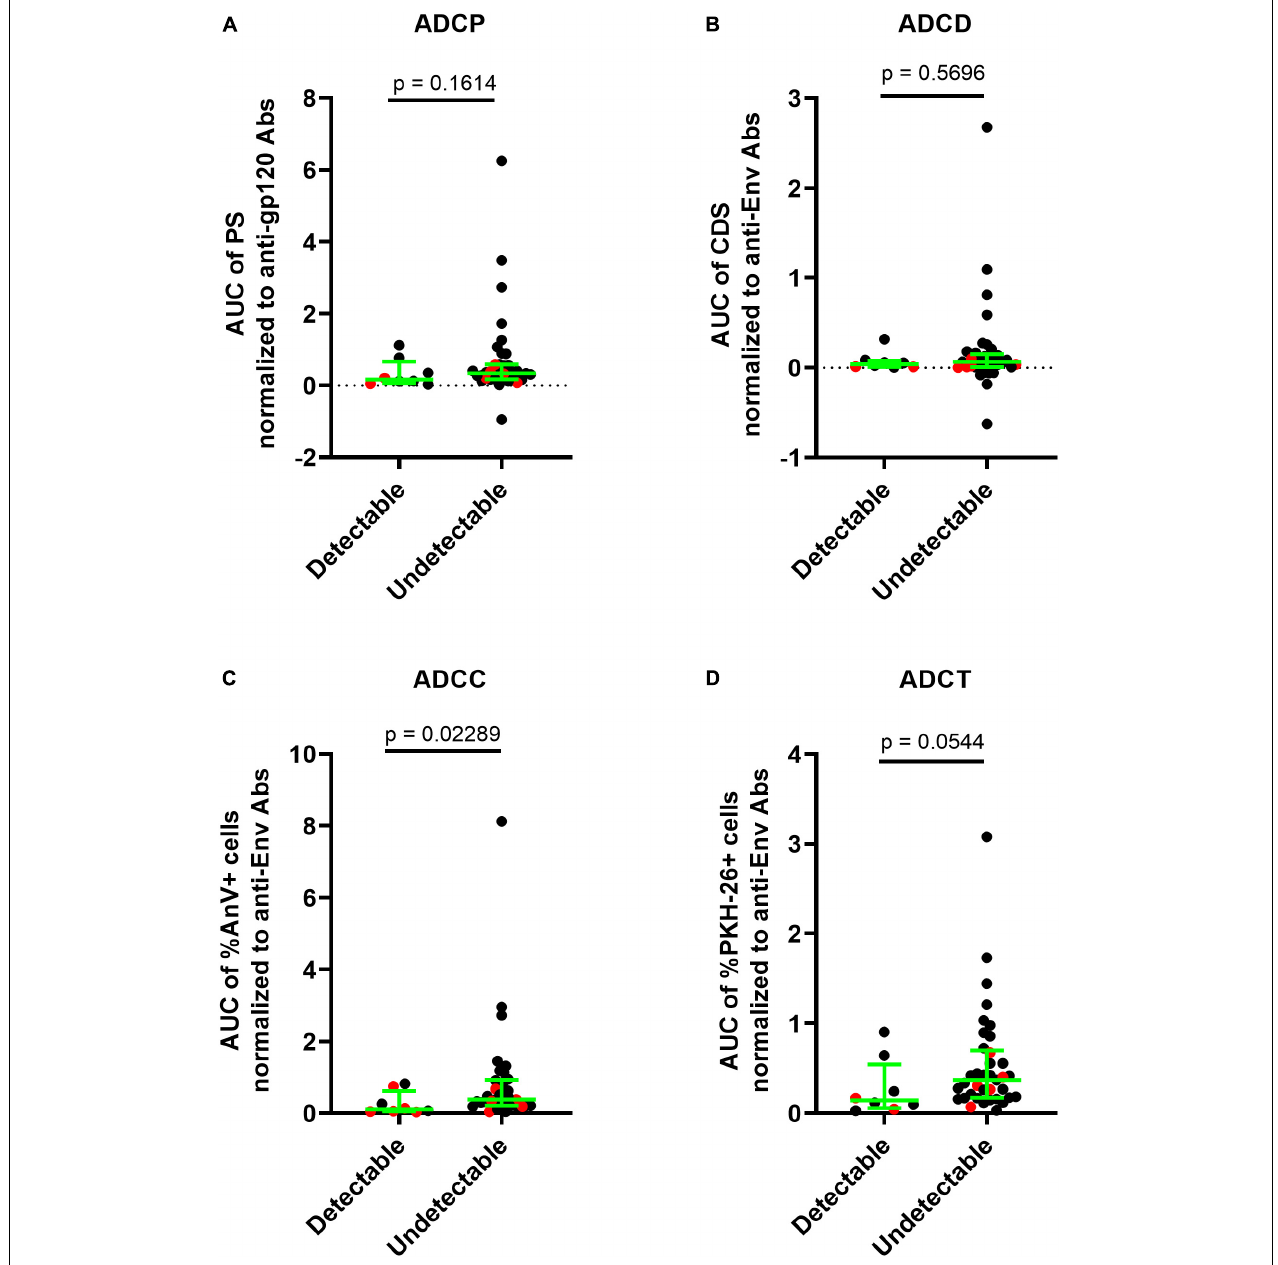
FIGURE 5 | Higher ADCC function in HIV controllers is associated an HIV reservoir size below the limit of quantification. The HIV reservoir size in 30 ECs and 16 VCs was measured using the integrated HIV PCR assay. Results were stratified into a group with detectable [n = 8, (3 EC and 5 VC)] and undetectable [(n = 38, 27 (EC and 11 VC)] HIV reservoir sizes. (A) The y -axis shows the levels of ADCP function normalized to the anti-gp120-specific Ab concentrations in HIV + plasma quantified using the PBE assay. (B–D) The y-axes show the levels of ADCD, ADCC, and ADCT functions, respectively, normalized to the anti-Env Ab concentration in HIV + plasma quantified using the siCEM binding assay. Each point represents a single subject. Results for ECs are illustrated in black and those for VCs in red. Lines and error bars though each data set represent medians and IQRs. The significance of between-group differences was assessed using Mann–Whitney tests. p -values are depicted above the lines linking groups being